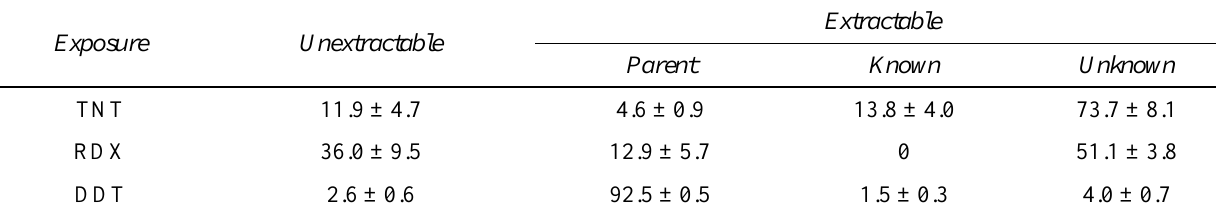
Table 2: Percent of total sum-molar concentrations in worm tissues corresponding to unextractable or extractable parent, known or unknown compounds. Numbers (1-4) represent mean ± 1 standard deviation. Unextractable is defined as compounds that are resistent to solvent extraction from tissue. Extractable compounds includes the parent compound, known, or identified, compounds and unknown compounds, which are more polar than the parent compound and were not identified.